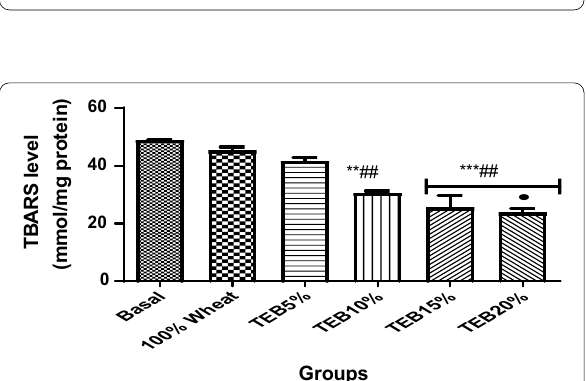
Fig. 16 Effect of enzymatic tacca–wheat biscuit on albino Wistar rats by TBARS level. 100% Wheat: Rats fed with 100% wheat flour biscuit, TEB5%: Rats fed with 5% enzymatic tacca flour flour biscuit, TEB10%: Rats fed with 10% enzymatic tacca flour wheat flour biscuit, TEB15%: Rats fed with 15% enzymatic tacca flour 85% wheat flour biscuit, TEB20%: Rats fed with 20% enzymatic + tacca